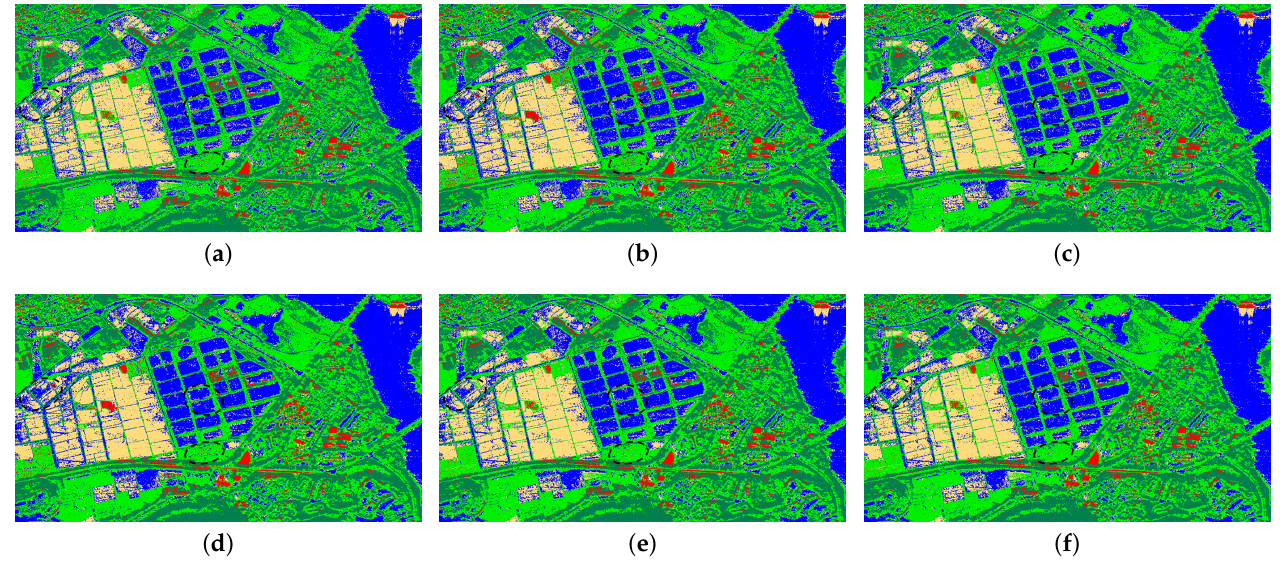
Figure 9. Classification maps of six algorithms on the Boao region. ( a ) WMM-MRF. ( b ) RWMM-MRF.